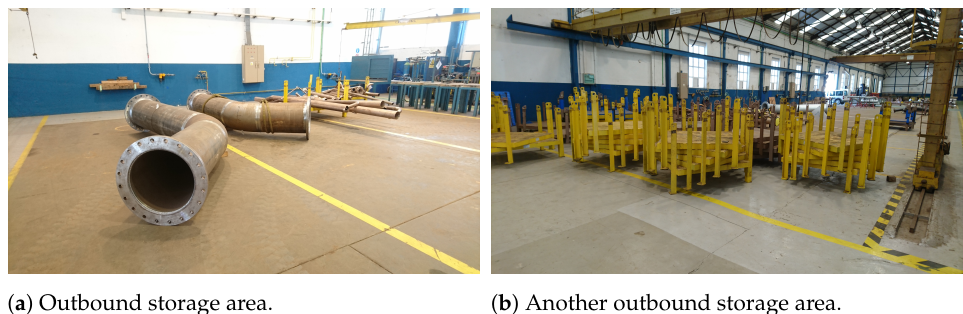
Figure 8. Main storage